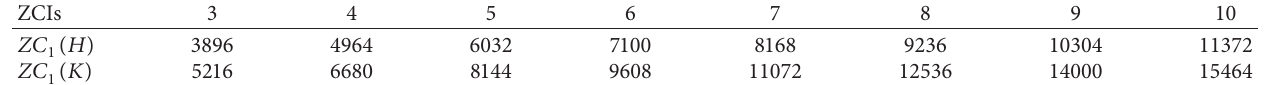
for H and K networks on dimensions 3 ≤ n ≤ 10. 1